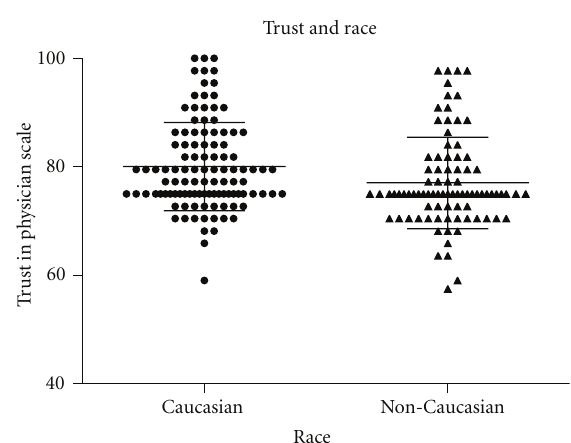
Figure 1: Scores on the Trust in Physician Scale (TPS), a test of interpersonal trust in the physician from the patients’ perspective, were plotted for Caucasian and for African American subjects. On the 0 to 100 scale, mean TPS score for the 108 Caucasian subjects was 80 . 1 ± 8 . 2 (mean ± SD) which was significantly higher than the mean TPS score for the 87 non-Caucasians, TPS 77 . 1 ± 8 . 4; P = . 012. The dark bars represent mean scores and whiskers indicate